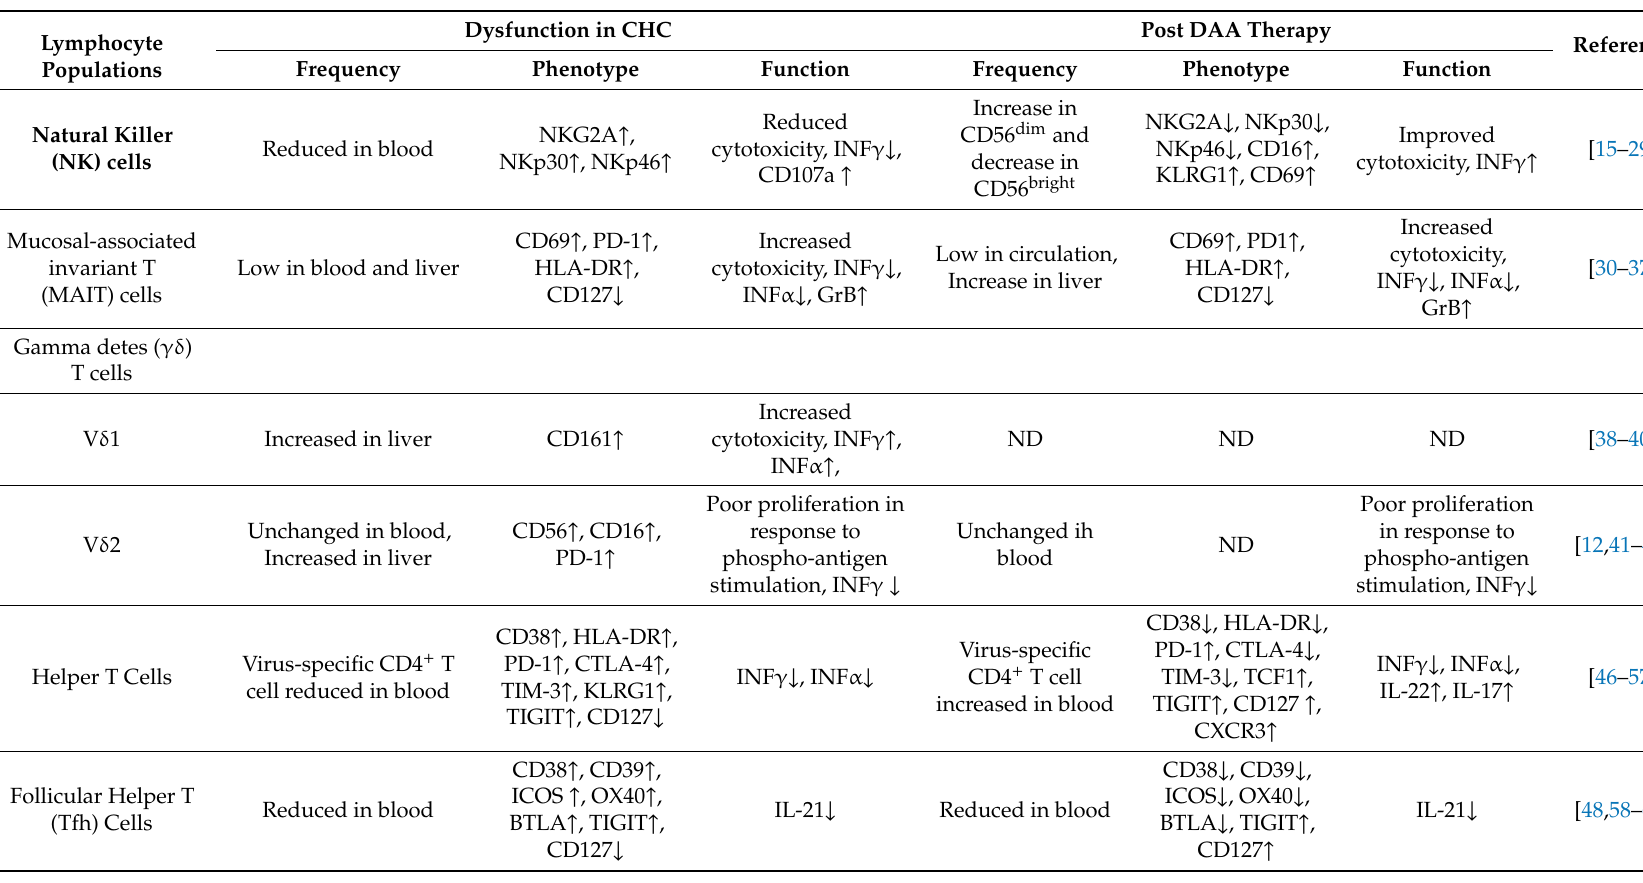
Table 1. Lymphocyte landscape present in a chronic hepatitis C virus (HCV)-infected patient and its status after virus clearance using direct acting antiviral (DAA)